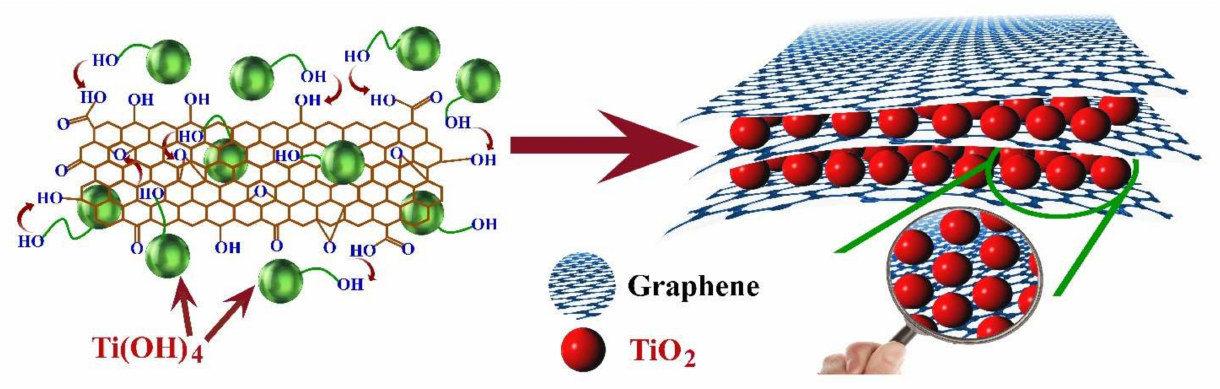
Figure 17. Schematic representation of the mechanism of the formation of the TiO 2 /graphene nanocomposite, wherein Ti(OH) 4 reacts with functional groups of GO sheets leading to the reaction of oxygen atoms with titanium precursor to form graphene/TiO 2 nanocomposites. Adapted and reproduced with permission from Ref. [83]. Copyright 2014